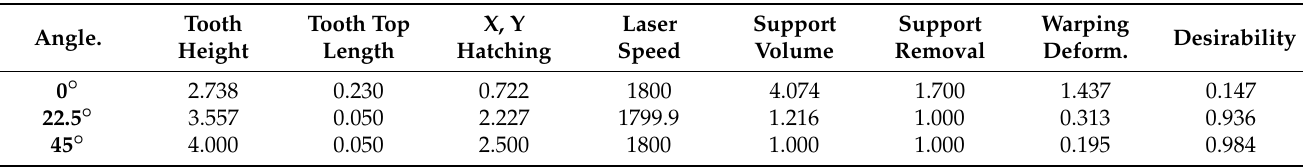
Table 10. Optimum results of 0 ◦ , 22.5 ◦ , and 45 ◦ overhangs.